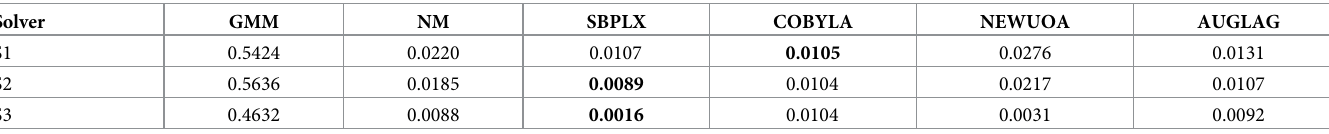
Table 3. Comparison of the optimized objective values regarding the optimization algorithms on the S-sets. The boldface indicates the best objective values in each subset.